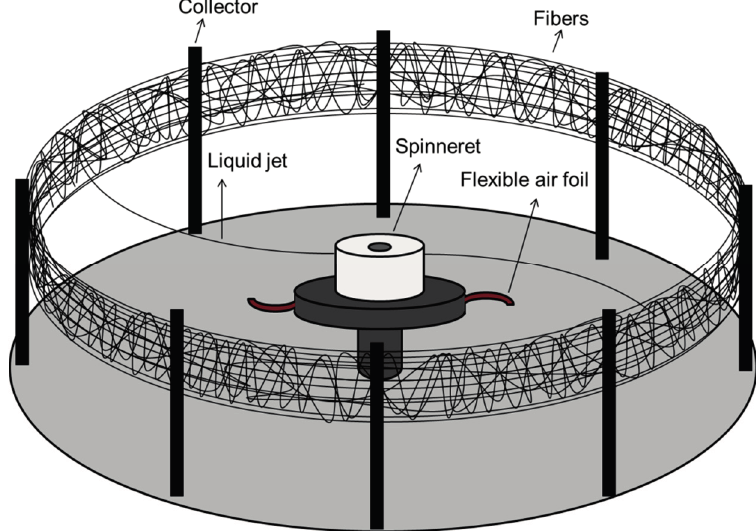
Figure 1. Schematic of centrifugal spinning